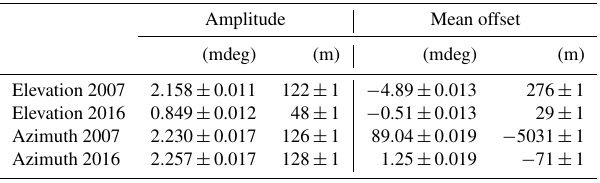
Table 4. The offset and amplitudes of the seasonal cycles of the functions fitted to the occultation mispointing angle with the mis- pointing parameters as defined in 2007 and with the newly fitted mispointing parameters (see Fig. 10). The values for the 2007 mis- pointing very slightly differ from the ones given in Bramstedt et al. (2012) because of the update in the orbit parameters (see Sect. A1) and a slightly changed set of available orbits in the Level 1b product version 8.